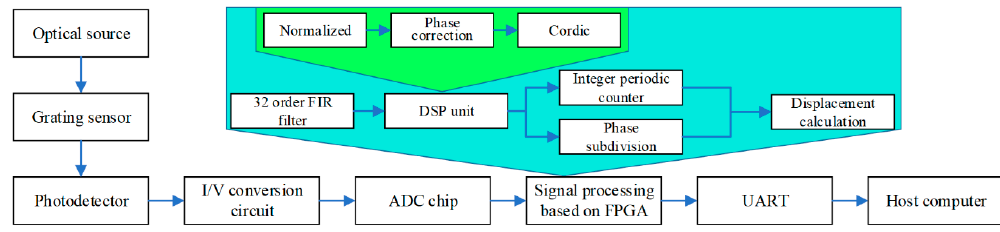
Figure 2. The overall process design of the displacement calculating platform.